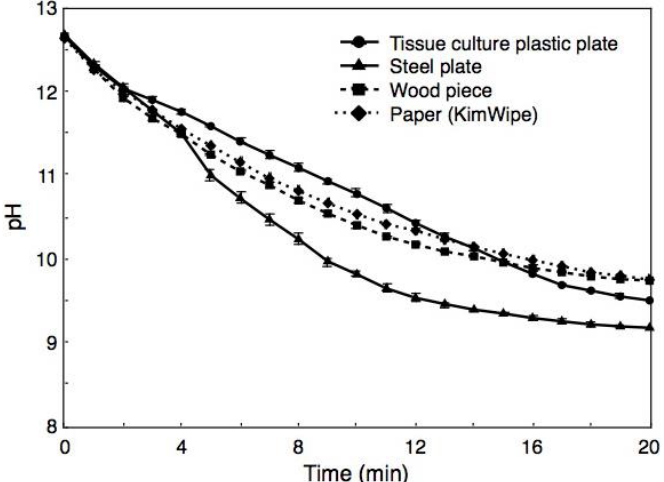
Figure 4. Changes of pH in BiSCaO Water sprayed on surfaces of materials. For all tested surfaces, the pH immediately after spraying was approximately 12.6, a value that was lower than the original pH of BiSCaO Water (i.e., pH 12.8). The pH on the surfaces continued to fall over the subsequent 20 min. Values are plotted as mean ± SD ( n = 4).